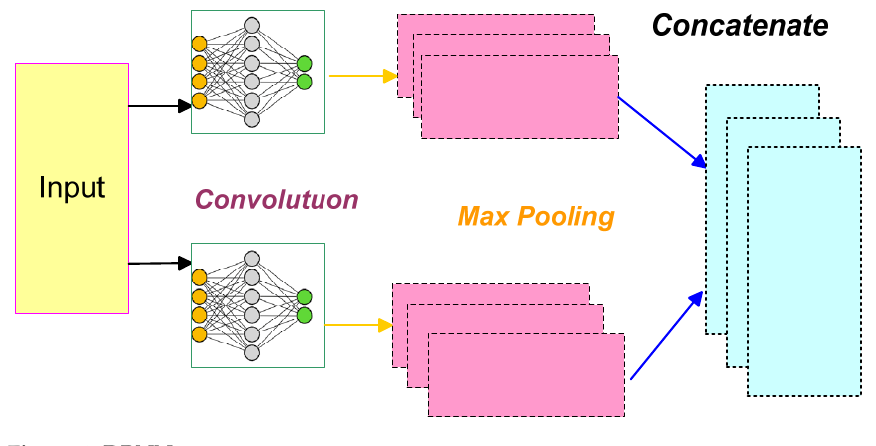
Figure 4. DRNN structure.